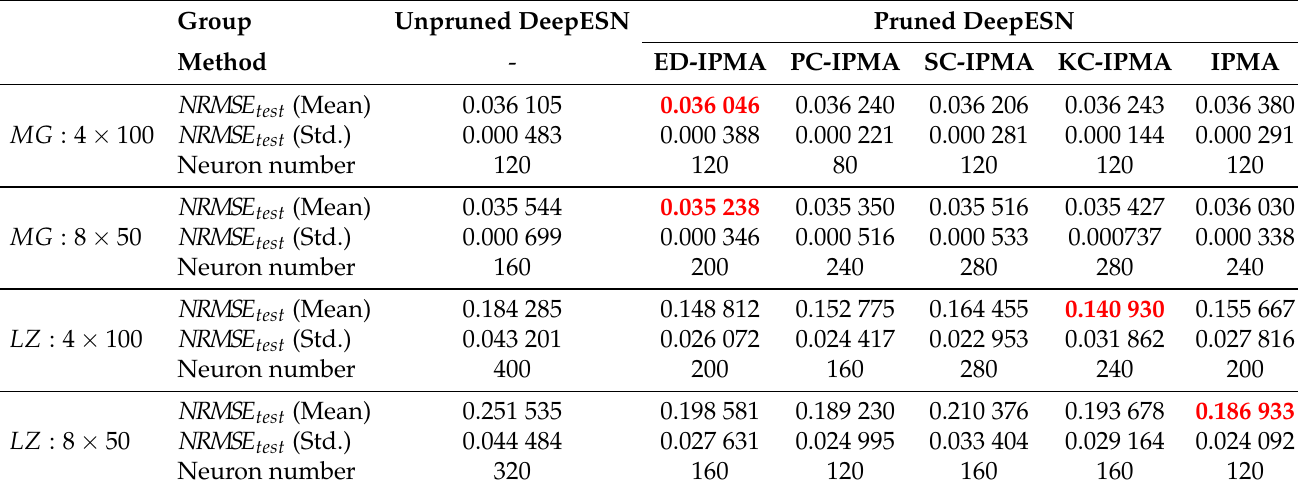
Table 1. Minimum testing NRMSE condition of each experiment